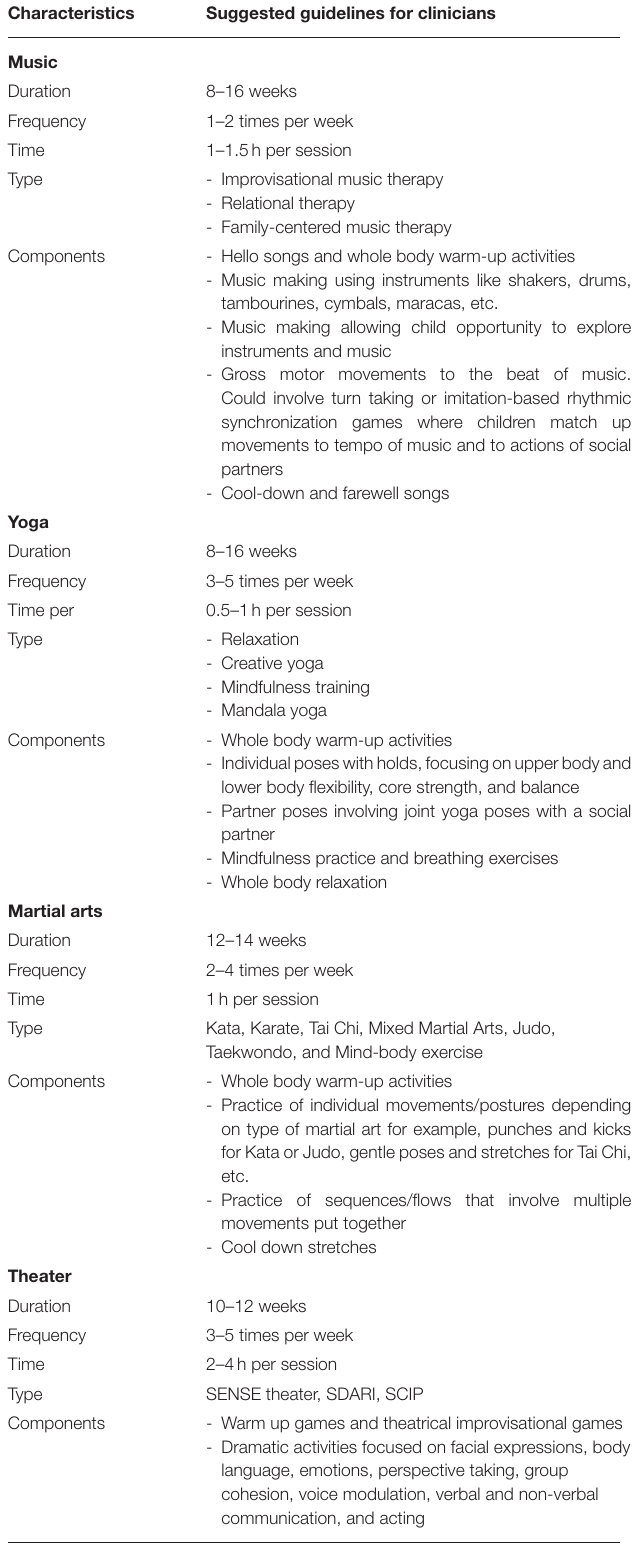
TABLE 5 | Intervention guidelines for CMT interventions based on reviewed